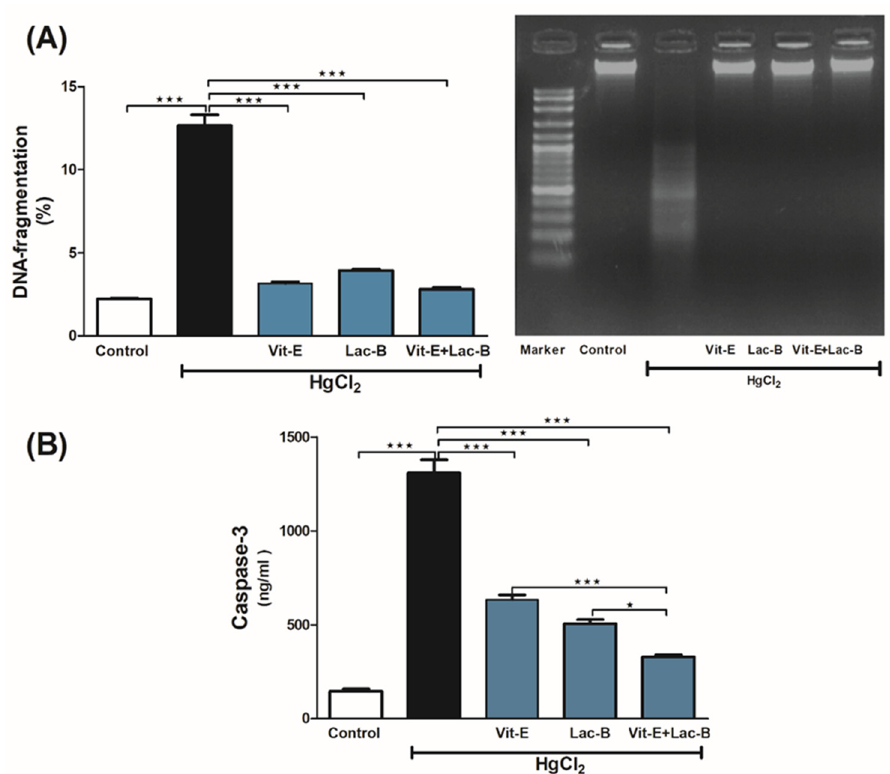
Figure 6. Vit-E and Lac-B suppressed renal apoptotic damage in HgCl 2 -intoxicated rats. ( A ) Representative blot is showing variations in the DNA fragmentation in all treated groups, ( B ) changes in renal tissue expression of Caspase 3 in all treatment groups. Data are expressed as mean ± SEM, ( n = 6). *** p < 0.001, * p < 0.05.